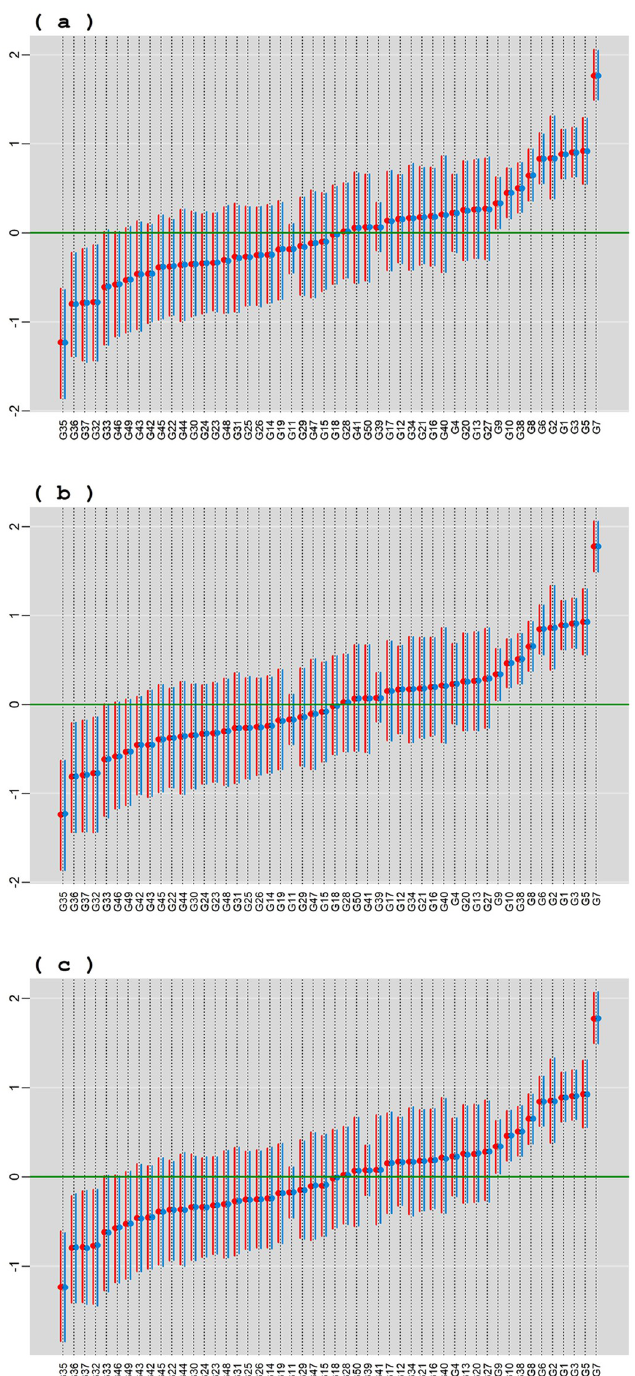
Fig 11. Posterior means and the 95% HPD intervals for the effect of genotypes, conditional response (blue color) and marginal responses (red color) referring to: a) BAMMI; b) BAMMIS; c) BAMMIE.